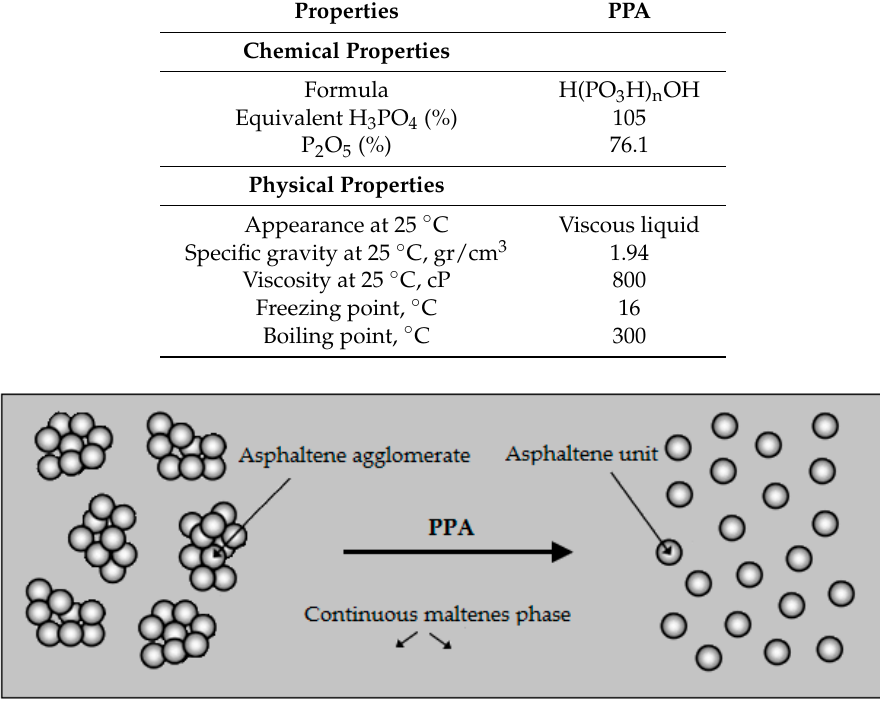
Figure 1. The function of PPA in asphalt binder [39].